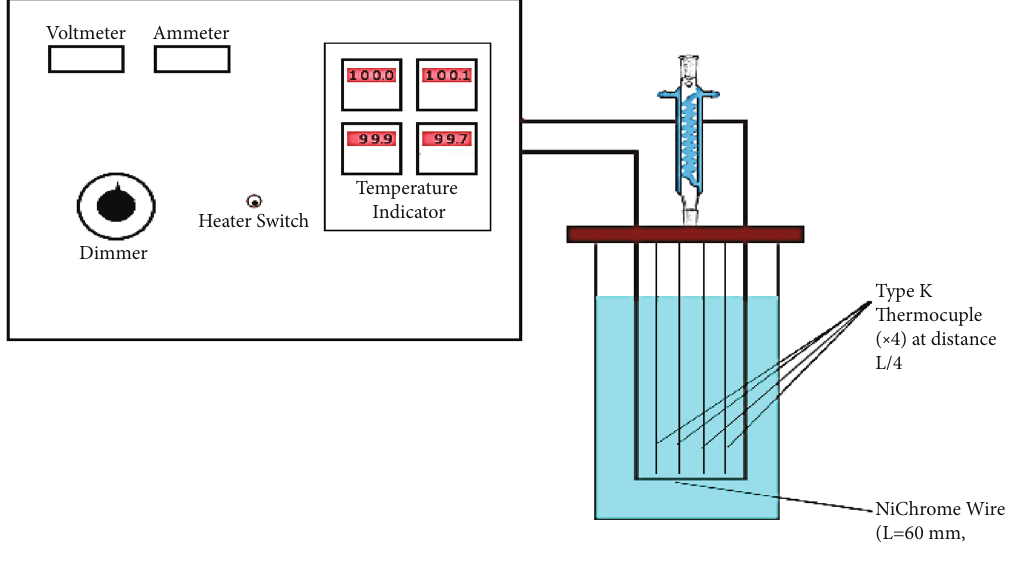
Figure 2: Experimental setup.